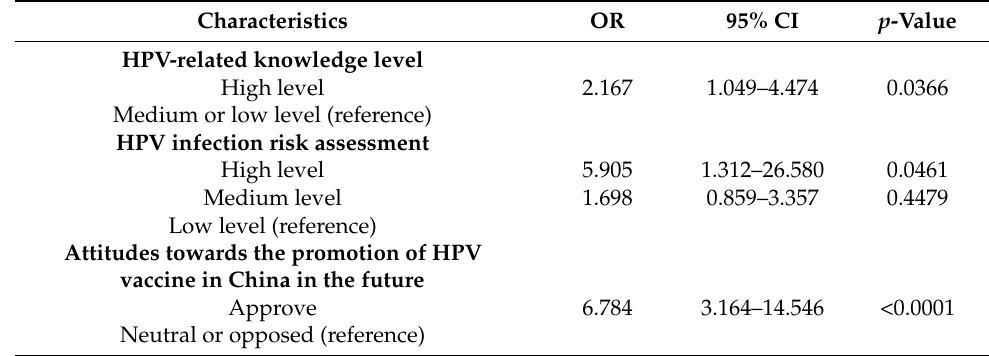
Table 6. Multivariate logistic regression analysis of HPV vaccination willingness in